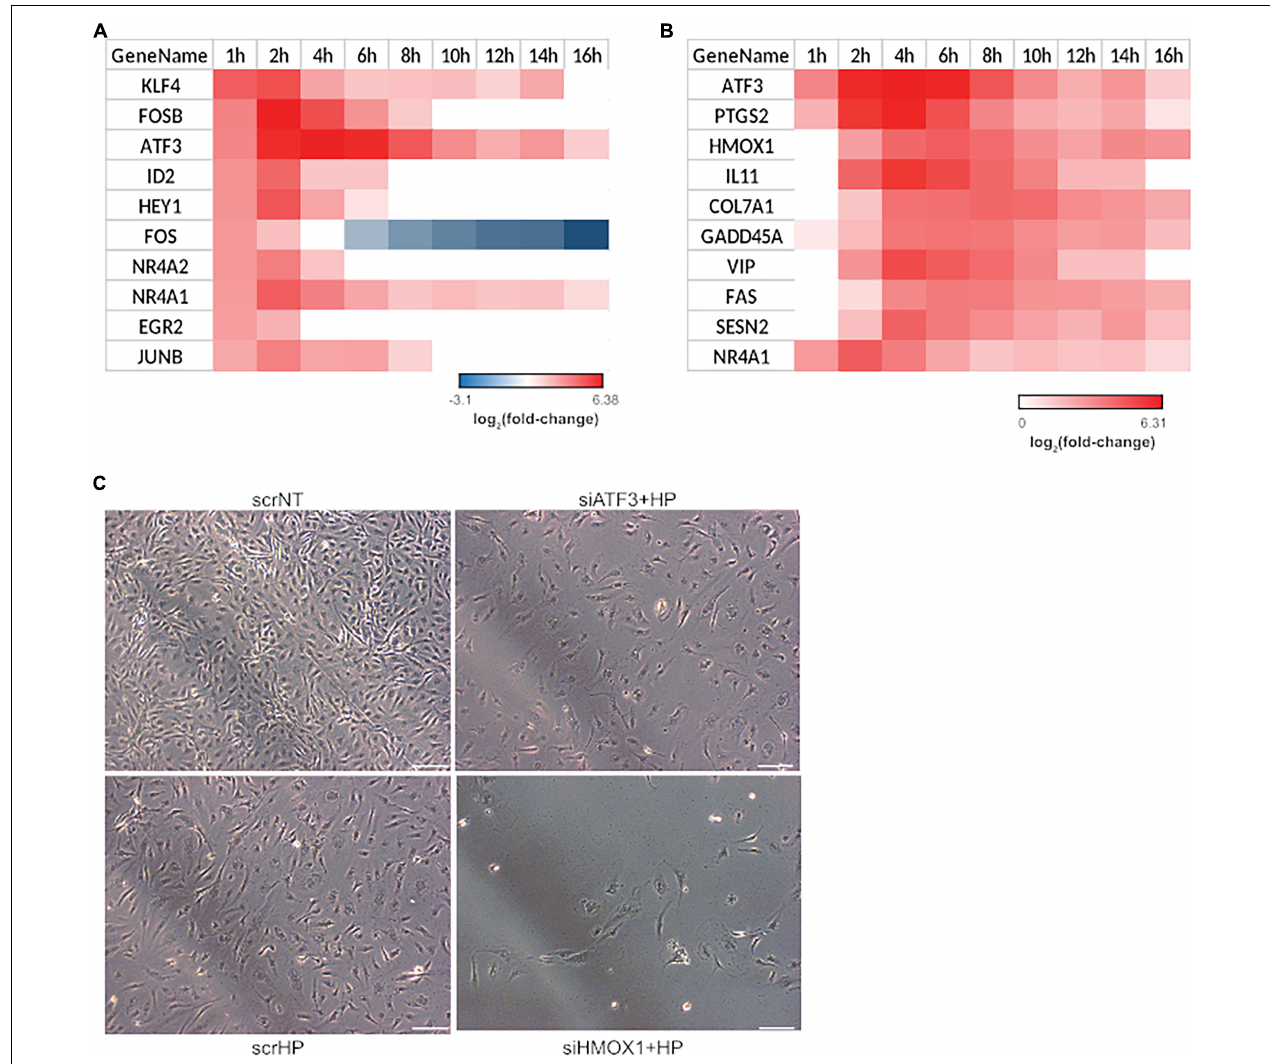
FIGURE 3 | HMOX1 is a key regulator of cell fate in HUVECs upon HP treatment. Significant transcription factor-target interactions were identified to determine key gatekeepers of cell fate and function. (A) Top 10 up-regulated transcription factors at 1-h post HP treatment. (B) The top 10 up-regulated gene targets of JUN family transcription factors. All JUN targets differentially expressed at least one-time points were identified and ranked by average fold-change across all time points. (C) Two genes were selected from (B) for a siRNA screen experiment: ATF3 and HMOX1. After 48 h of transfection and 6 h of HP treatment, HUVECs were imaged using phase-contrast microscopy (the images shown are the representative images taken from 3 repeats of the experiment; scale bars indicate 100 µ